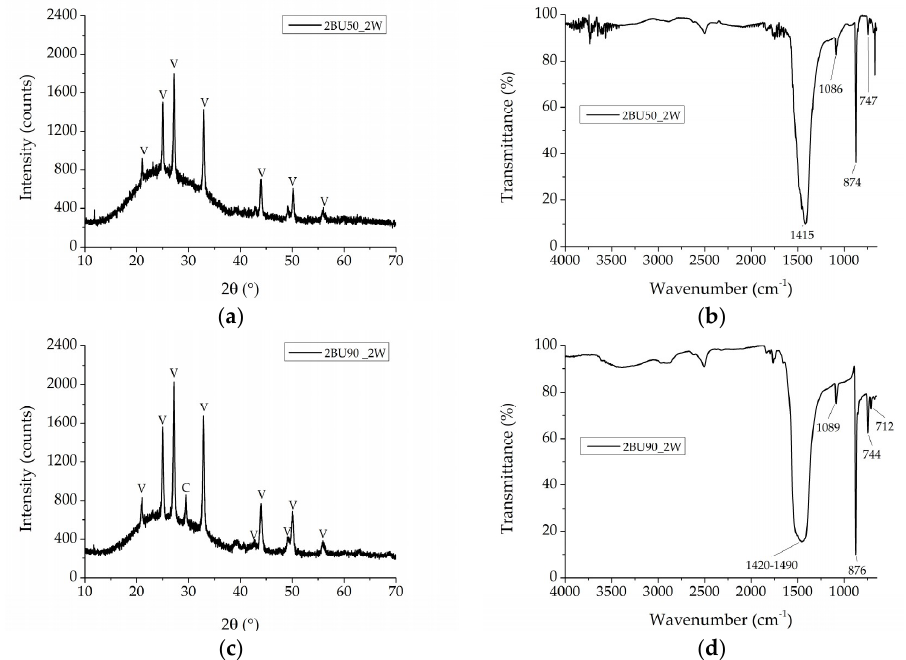
Figure 5. X-ray diffraction (XRD) and μFT-IR analyses of 2BU after two weeks: ( a ) XRD pattern at 50% relative humidity (RH) (2BU50_2W) ( b ) μFT-IR spectrum at 50% RH (2BU50_2W), ( c ) XRD pattern at 90% RH (2BU90_2W) and ( d ) μFT-IR spectrum at 90% RH (2BU90_2W). XRD peak assignments: C, calcite; V, vaterite.